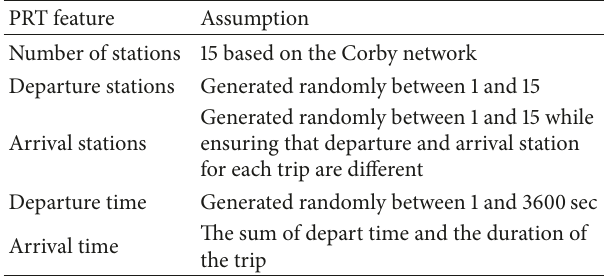
Table 1: Generated trips